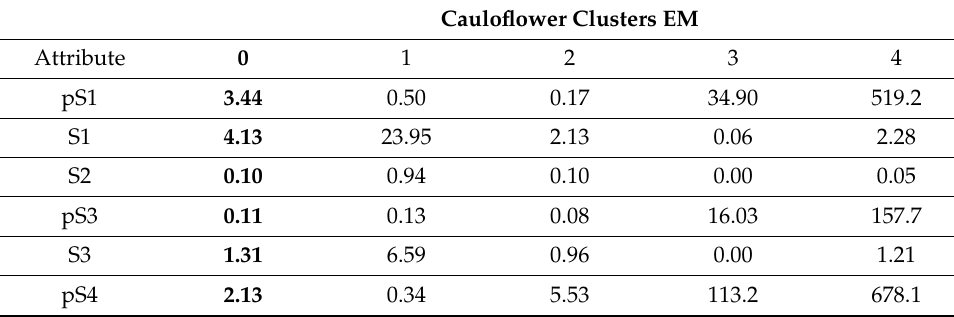
Table 11. EM clusterization of cauliflower